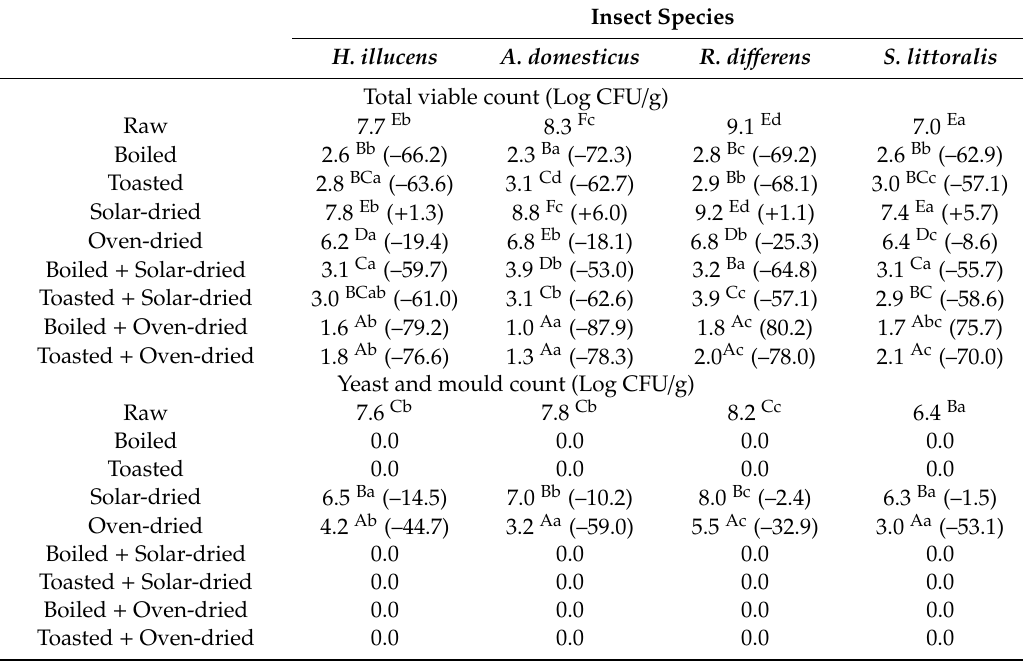
Table 3. Total viable counts and yeast and mould counts on raw and processed products.